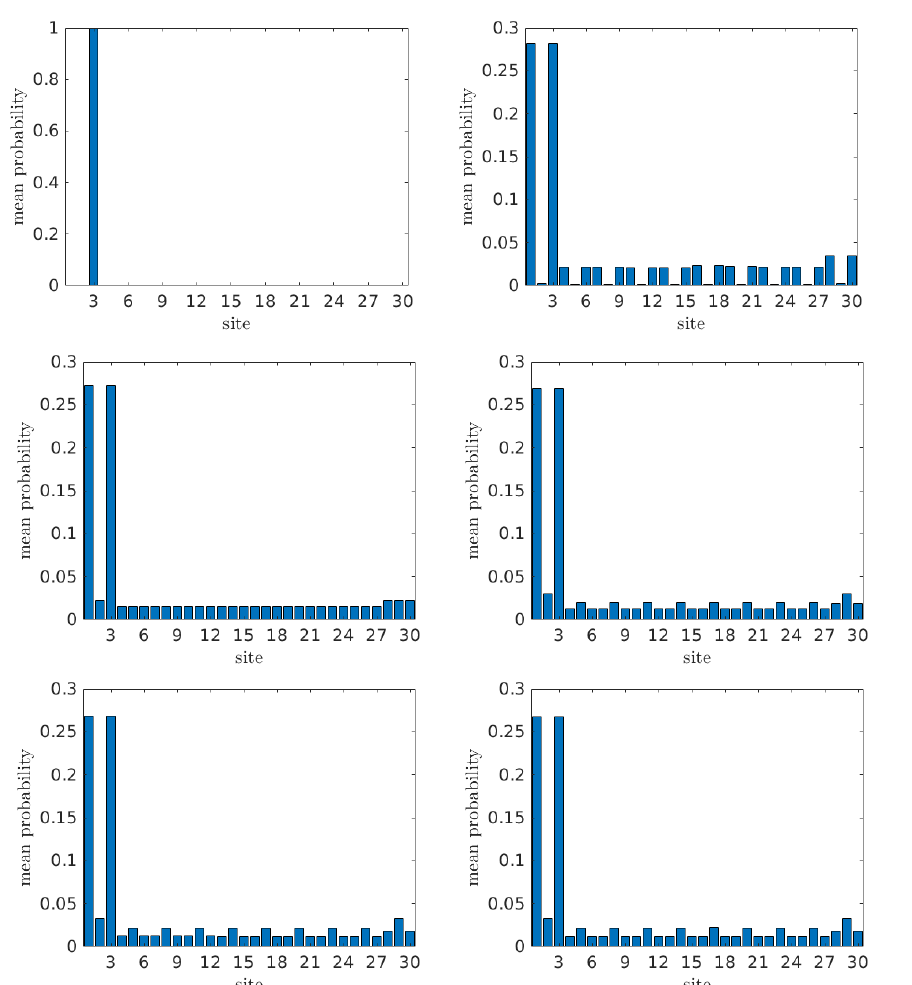
Figure 5. The mean-over-time probability at each site β , (cid:104)| C β ( t ) | 2 (cid:105) for a G... homopolymer with N = 10 for t S = 0.0, 0.1, 0.5, 1.0, 1.5, and 2.0 eV (from left top to bottom right) with initial hole placement at the “right” deoxyribose of the first monomer ( α =